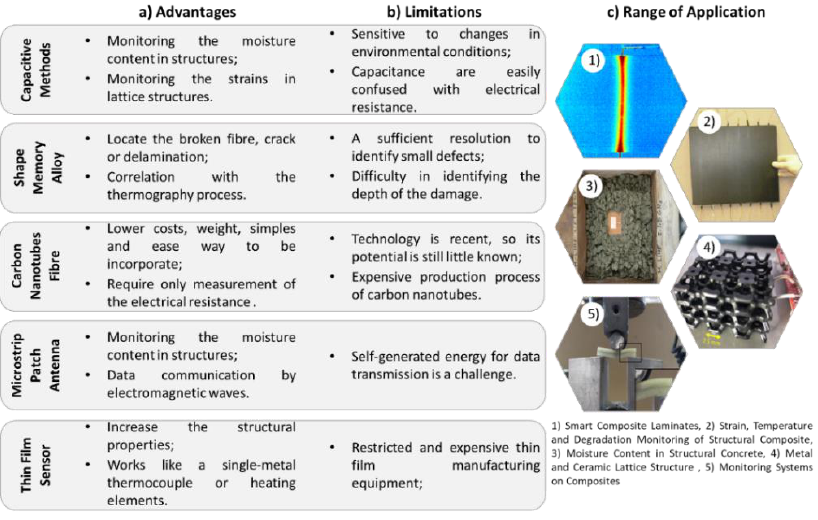
Figure 8. Other embedded sensors for composite components.